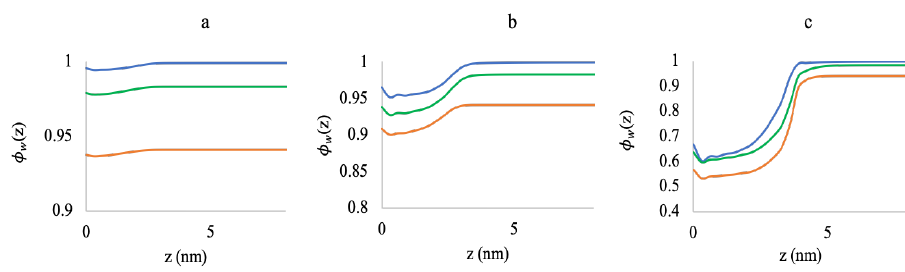
Figure 9. Water volume fraction profiles as a function of distance from the grafting surface at ( a ) 0.005 chains/nm 2 , ( b ) 0.05 chains/nm 2 , and ( c ) 0.5 chains/nm 2 grafting densities for 0 mM (blue lines), 50 mM (green lines), and 180 mM (yellow lines) MgCl 2 salt concentrations. Note the different scales of the plots (a,b,c).